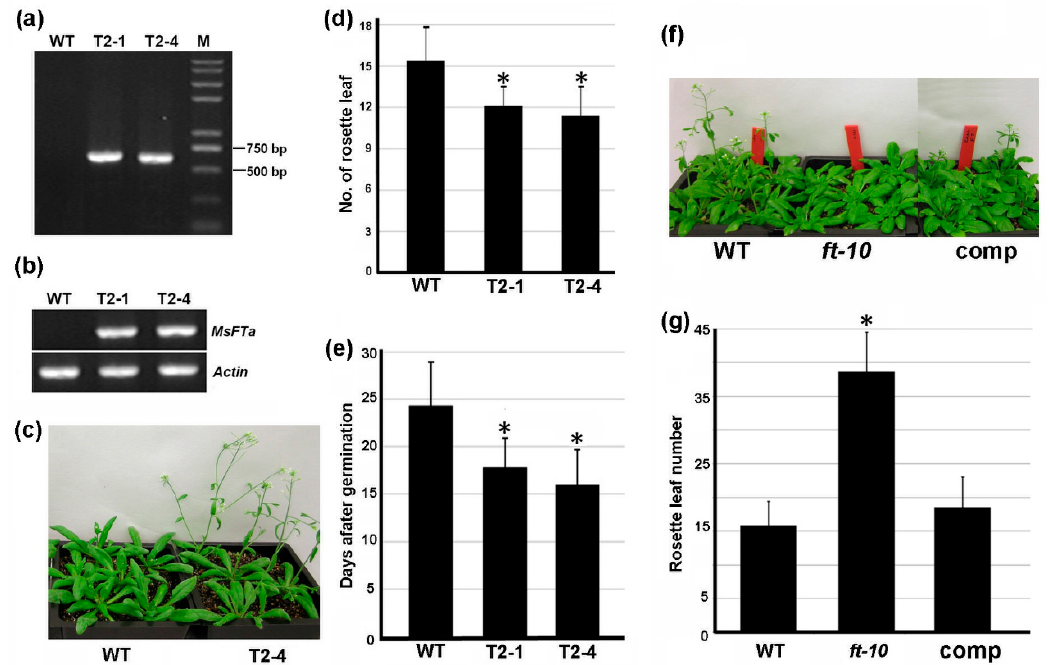
Figure 6. Ectopic expression of MsFTa in Arabidopsis caused early flowering. ( a ) Verification of two independent transgenic Arabidopsis lines (T2-1 and T2-4 of the T2 generation) harboring 35S::MsFTa construct by PCR. ( b ) Transcriptional analysis of MsFTa in the two transgenic lines verified in ( a ). Arabidopsis Actin 2 ( AT3g18780 ) was used as internal control. Leaves from two-week old plants were harvested for total RNA extraction. ( c ) Three-week-old plants of Col-0 and MsFTa over-expressing line (T2-4). ( d , e ) Flowering time analysis of the over-expression T2 plants grown under LD conditions in terms of days after germination ( d ) and no. of rosette leaves ( e ). At least 15 plants from three batches were scored for each line. The significant difference between the two genotypes was indicated as * (Student’s t -test, p < 0.05). ( f ) Four-week-old plants of Col-0, ft-10 and the transgenic ft-10 expressing 35S::MsFTa ( MsFTa / ft-10 ), showing rescued flowering time. ( g ) Statistical analysis of the no. of rosette leaves upon the emergence of the first flower. * indicated the significant difference between wild type and ft-10 (Student’s t -test, p < 0.05).